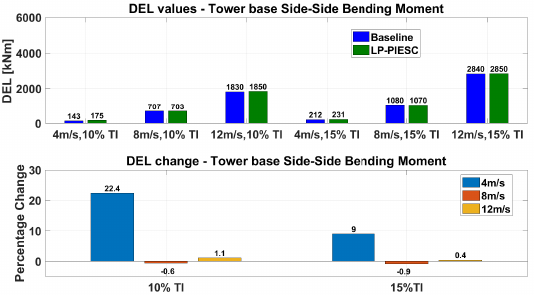
Figure 17. Tower-base side-side bending moment comparison: Baseline vs. LP-PIESC. Aggregate DEL values with baseline controller and LP-PIESC ( top ), percentage change in DEL ( bottom ) for time series from 150 s to 3000